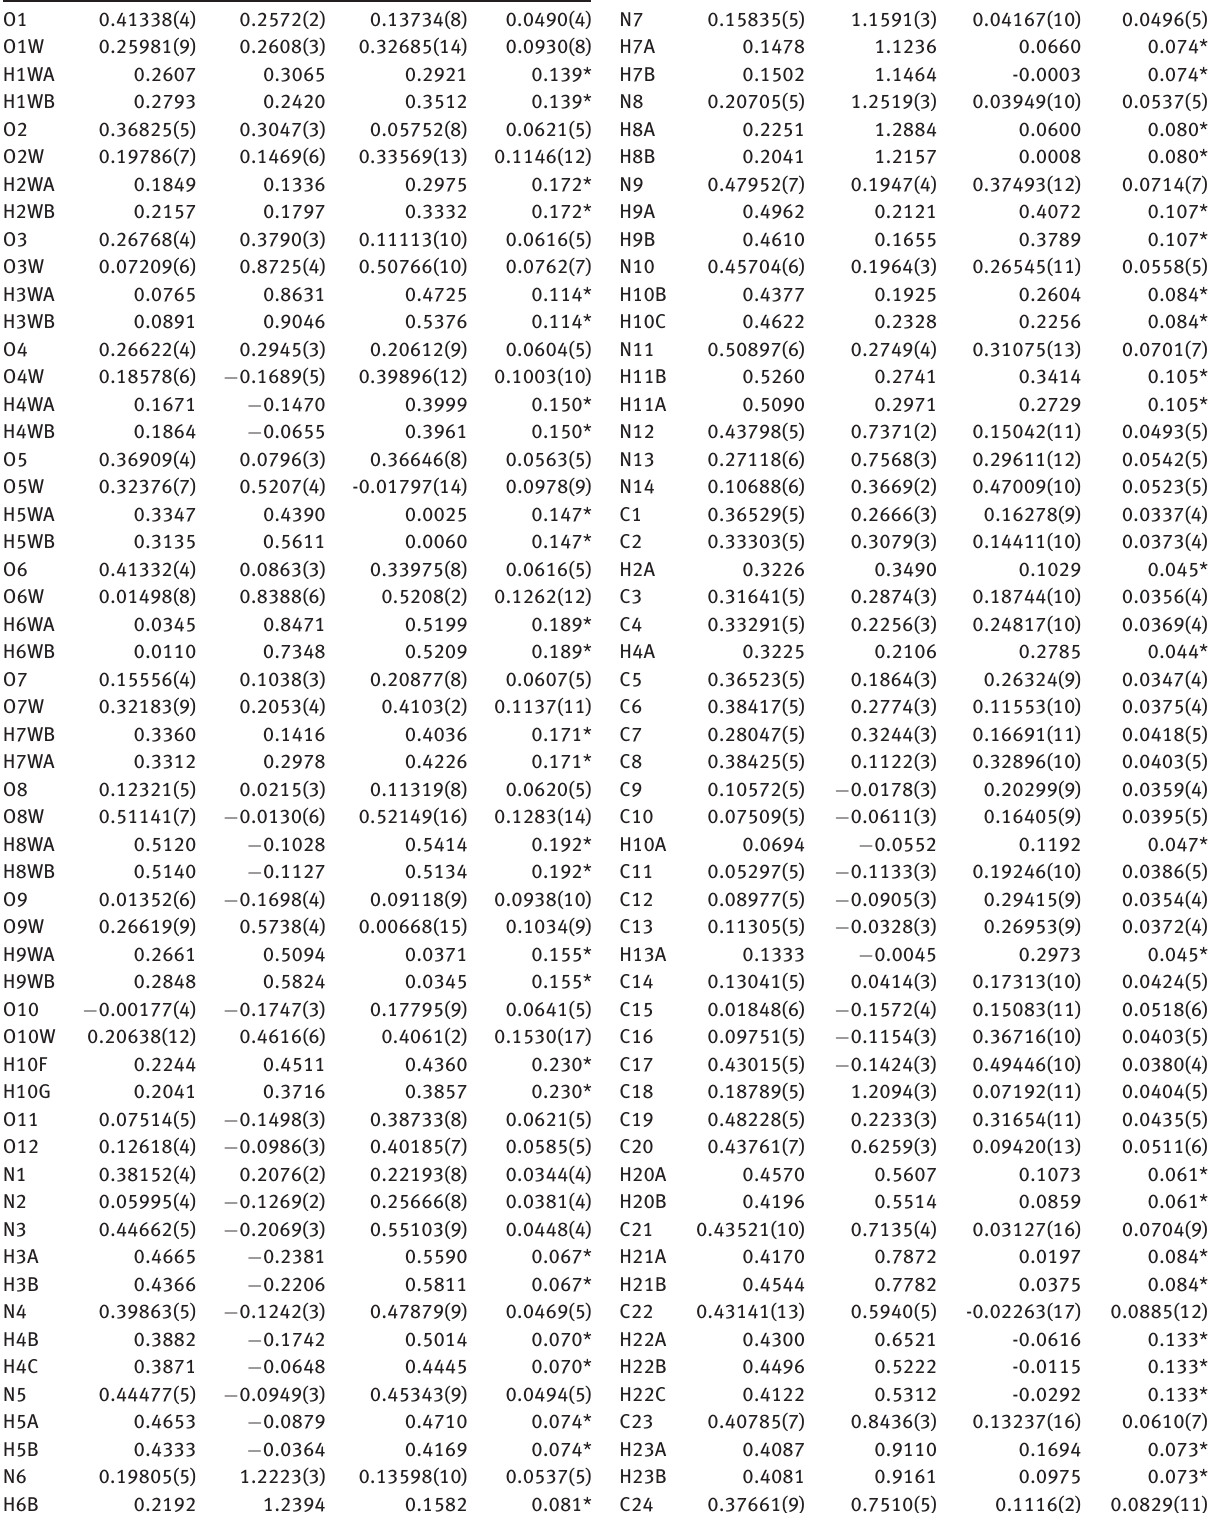
Table 2: Fractional atomic coordinates and isotropic or equivalent isotropic displacement parameters (Å 2